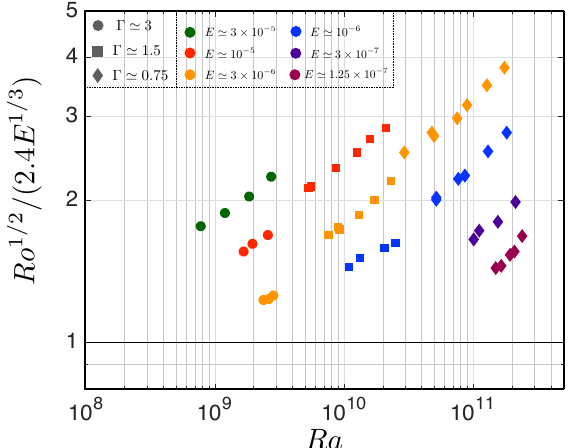
Figure 9. The turbulent length scale, (cid:96) turb = Ro 1/2 , normalized by the onset scale, (cid:96) crit = 2.4 E 1/3 , for the experimental data of this study. The symbol shapes and colors are consistent with those in Figure 8a,b. The ratio (cid:96) turb / (cid:96) crit is of order unity for all experiments